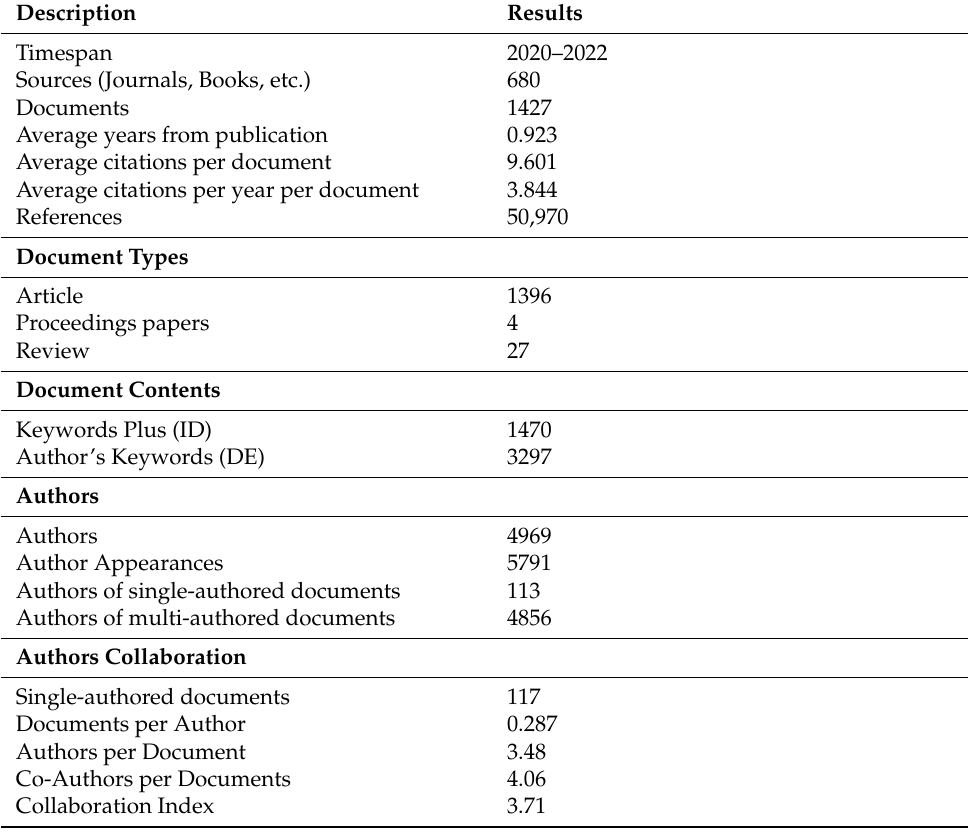
Table 1. Main information about the bibliographic